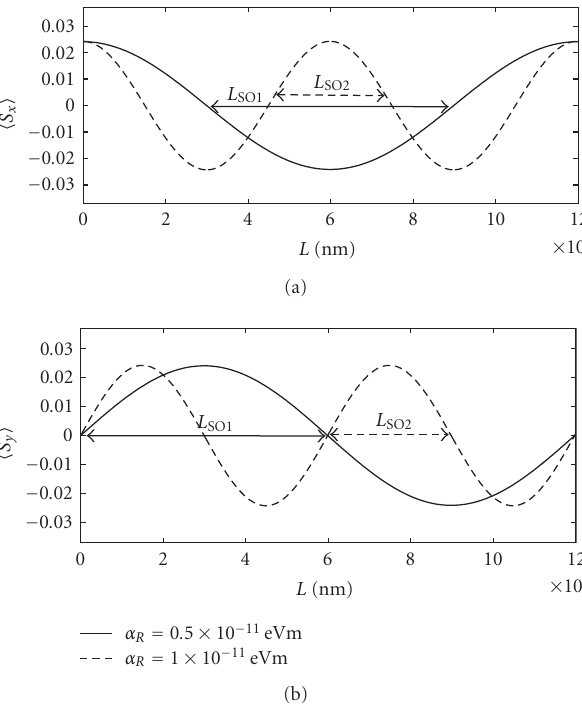
Figure 3: The intrinsic oscillations of spin polarization components (cid:2) S (cid:3) and (cid:2) S (cid:3) for α = 0 . 5 × 10 − 11 eVm (dashed line) and α x y R 1 . 0 × 10 − 11 eVm (solid line) with n = 4 and the transverse position u = 0 .